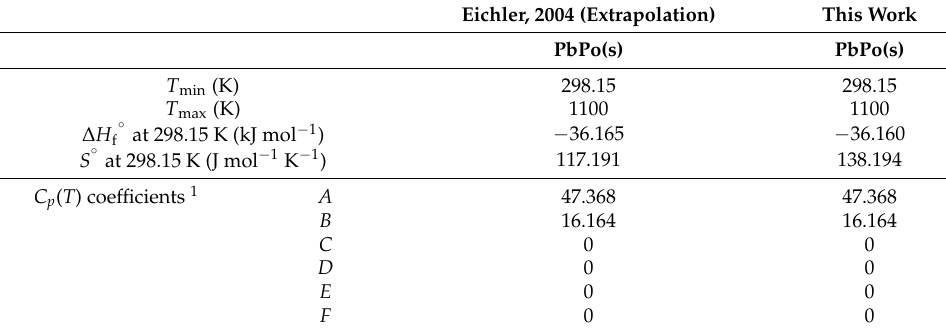
Table 4. Thermochemical data for